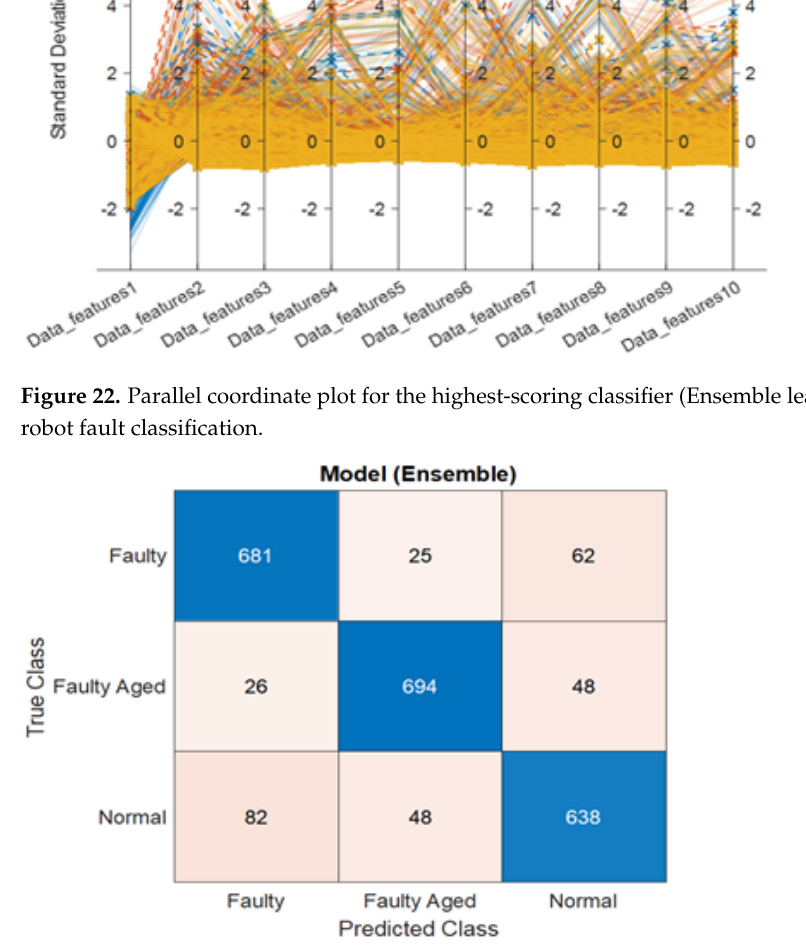
Figure 23. Confusion matrix for the highest-scoring classifier (Ensemble learning) for Hyundai robot fault